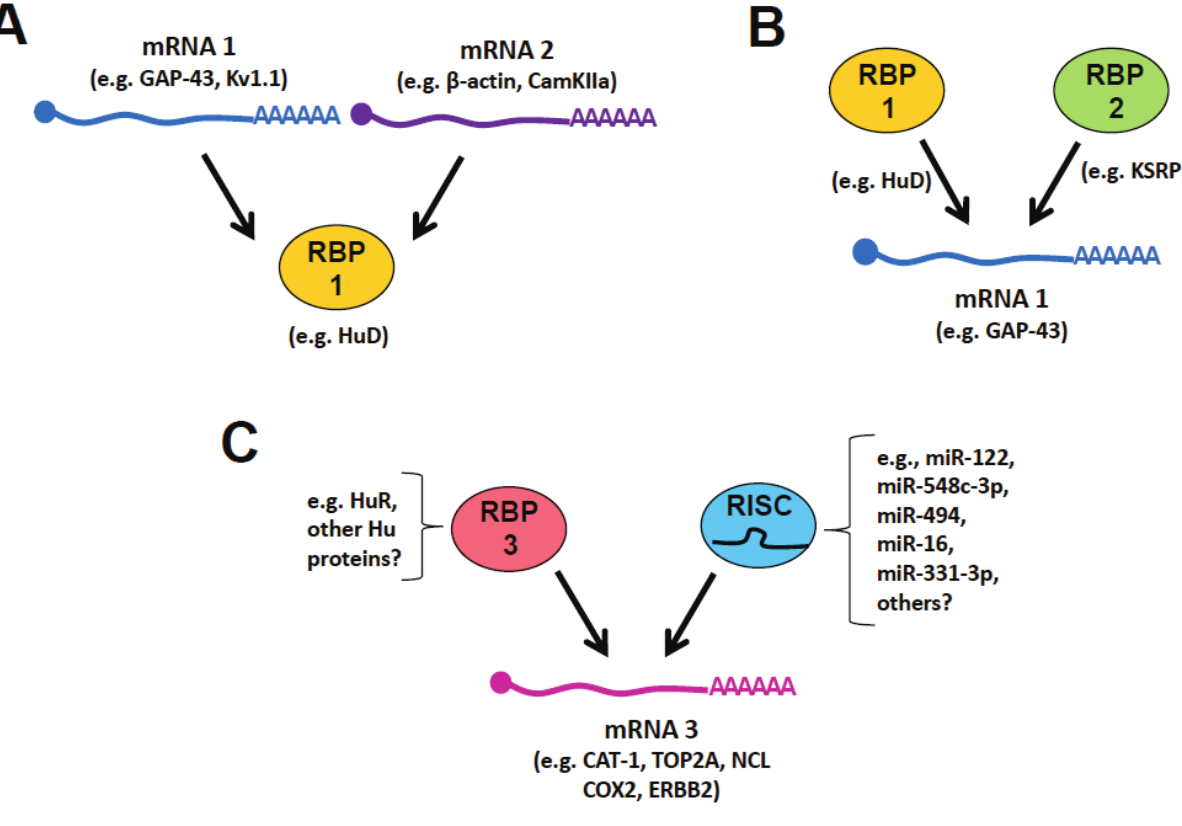
Figure 1. Examples of competing RBP target interactions: ( A ) mRNA1 and mRNA 2 compete for binding to RBP1; ( B ) RBP1 competes with RBP2 for binding to mRNA 1; and ( C ) RBP1 competes with the miRNA-associated RISC complex for binding to mRNA